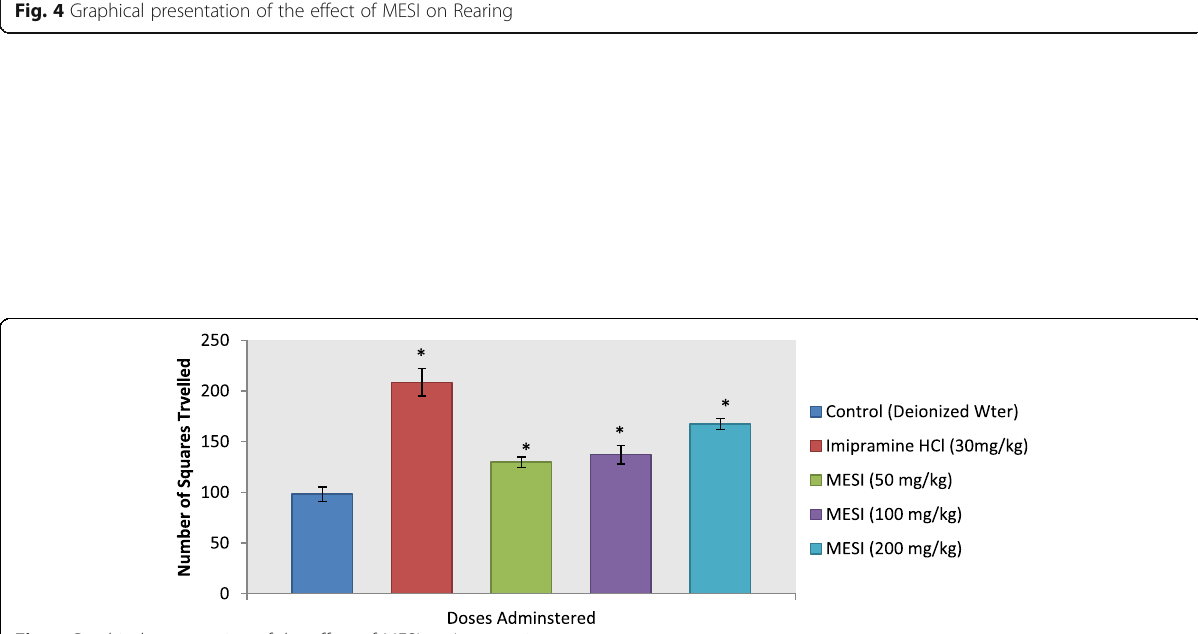
Fig. 5 Graphical presentation of the effect of MESI on